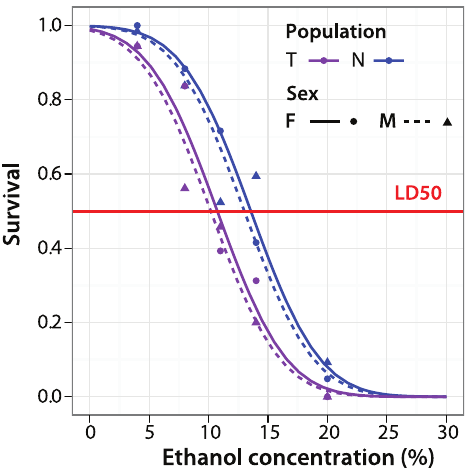
Figure 3. Netherlands flies have higher ethanol tolerance. Ethanol tolerance measured in duplicates for each sex in four lines from both the Netherlands and Tasmania. Red line indicates a survival rate of